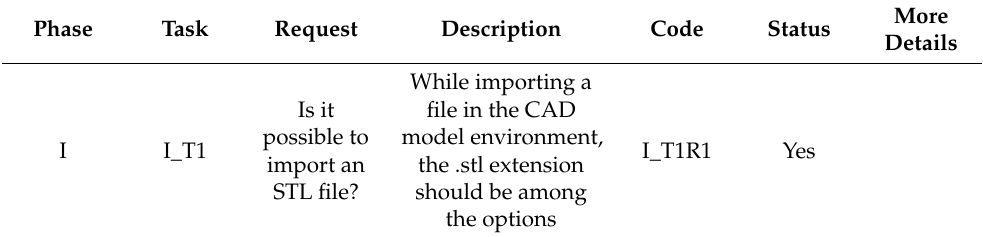
Table 2. Example of a matrix raw and analysis pattern for a